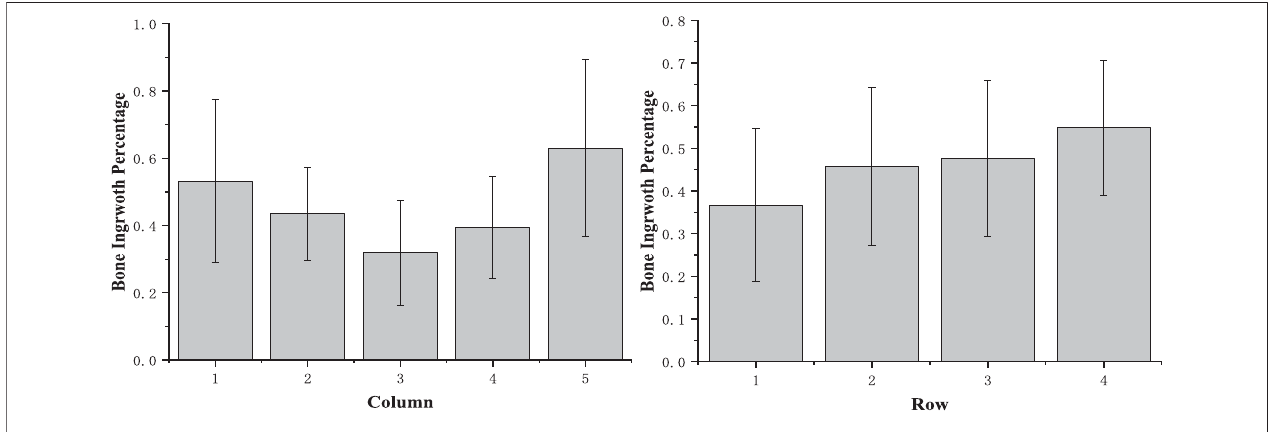
FIGURE 8 | Osteogenesis of scaffold vertical and horizontal